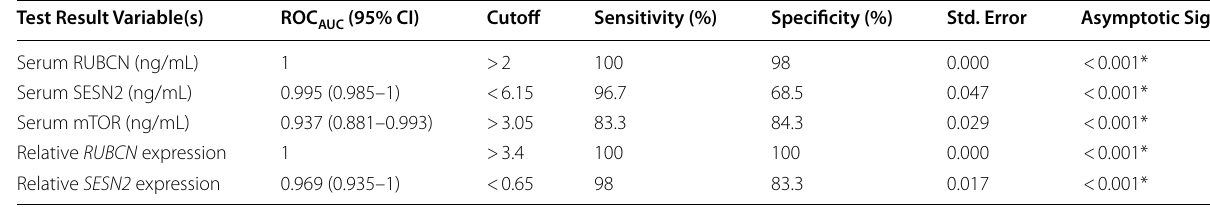
* Indicates statistical significance (P < 0.05); All calculated P were <